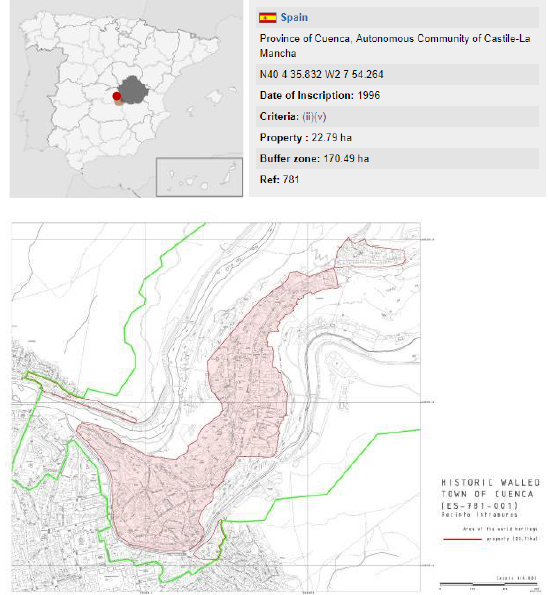
Figure 1. General data and area declared by